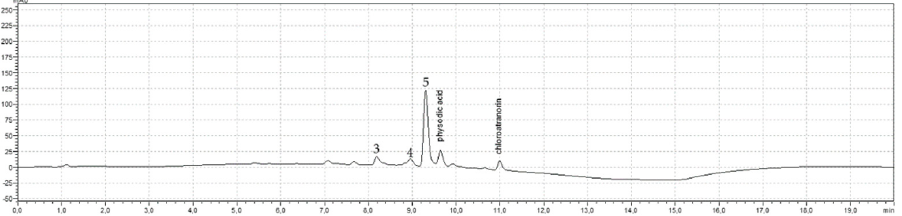
Figure 8. The chromatogram of acceptor solution of extract from Hypogymnia physodes . Physodic acid (t R = 9.64 min) and chloroatranorin (t R = 10.99 min) are the identified compounds visible in the acceptor chromatogram. Compounds 3, 4, and 5 are characterized by t R = 8.19, 8.96, 9.31 min, respectively.